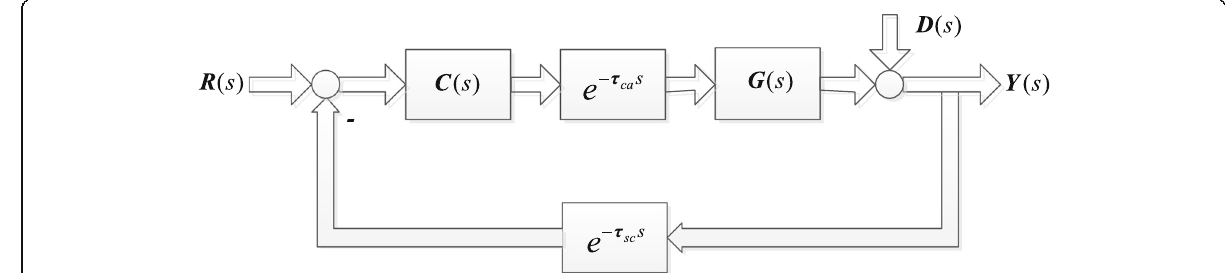
Fig. 2 The simplified structure of MIMO NCS